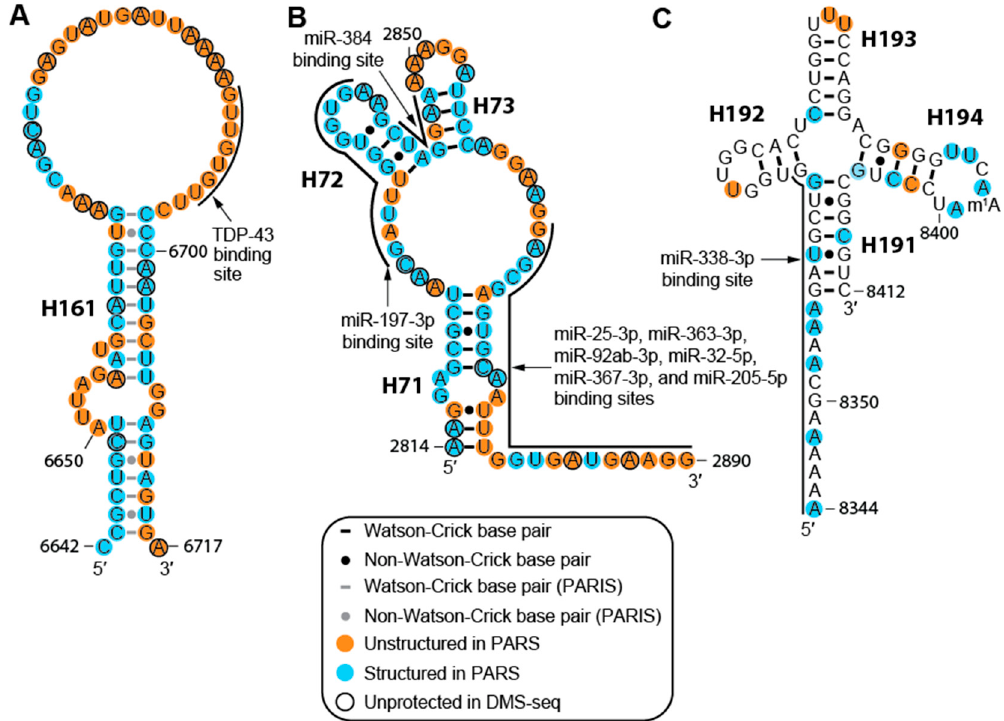
Figure 4. Select protein- and miRNA-binding sites mapped onto the MALAT1 structural model. ( A ) The TDP-43 binding site at the predicted loop of H161 consists of single-stranded UG / GU repeats [10]. ( B ) H71-H73 have eight miRNA-binding sites. Of these, miR-25-3p, miR-205-5p, and miR-363-3p have been experimentally validated, while the other miRNA binding sites are predicted based on starBase, a repository of putative and experimentally validated interacting partners of RNAs [15,44–46]. ( C ) Select triple helix-forming nts (8345–8355) and the 5 ′ stem of H191 contain a validated binding site for miR-338-3p [47]. All PARS, DMS-seq, and PARIS data are annotated as in Figure 2.